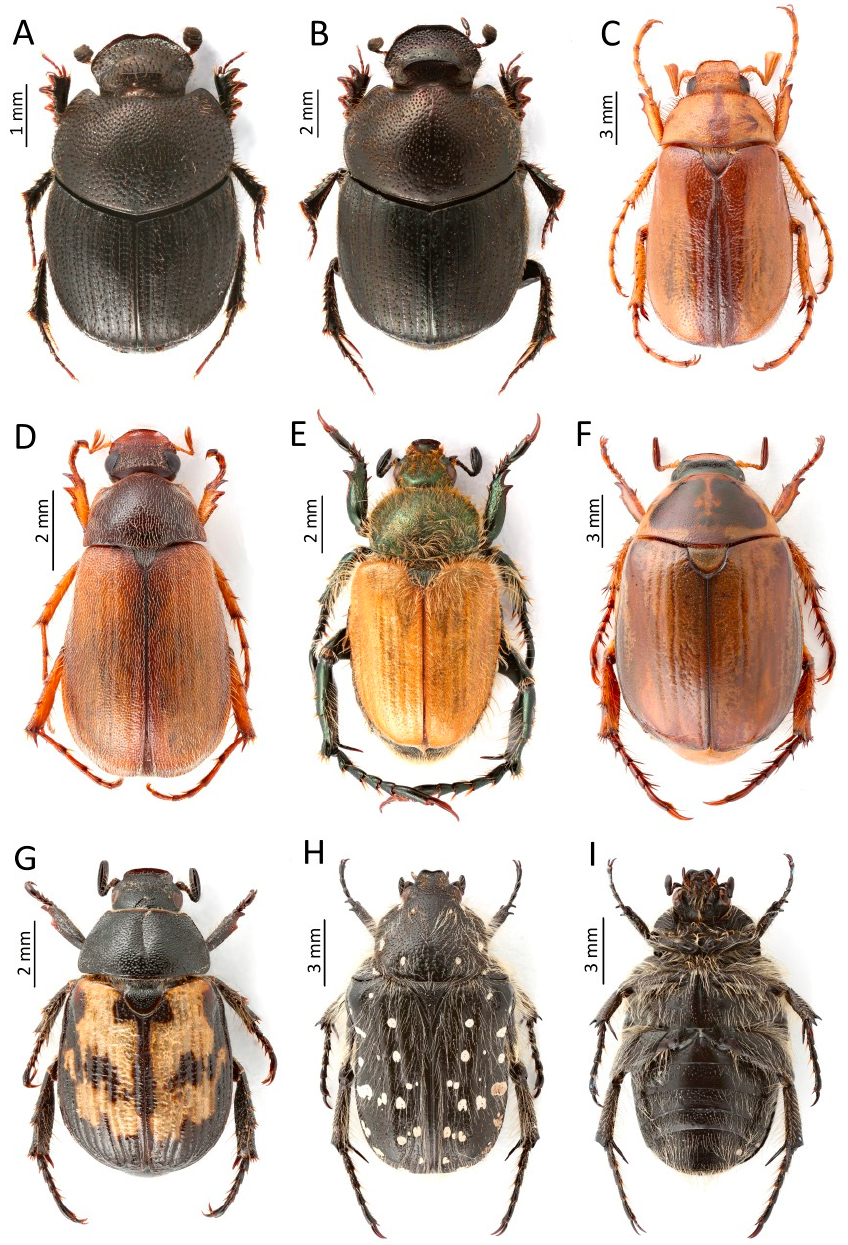
Figure 7. Rare and new species for the fauna of Montenegro were recorded in the course of